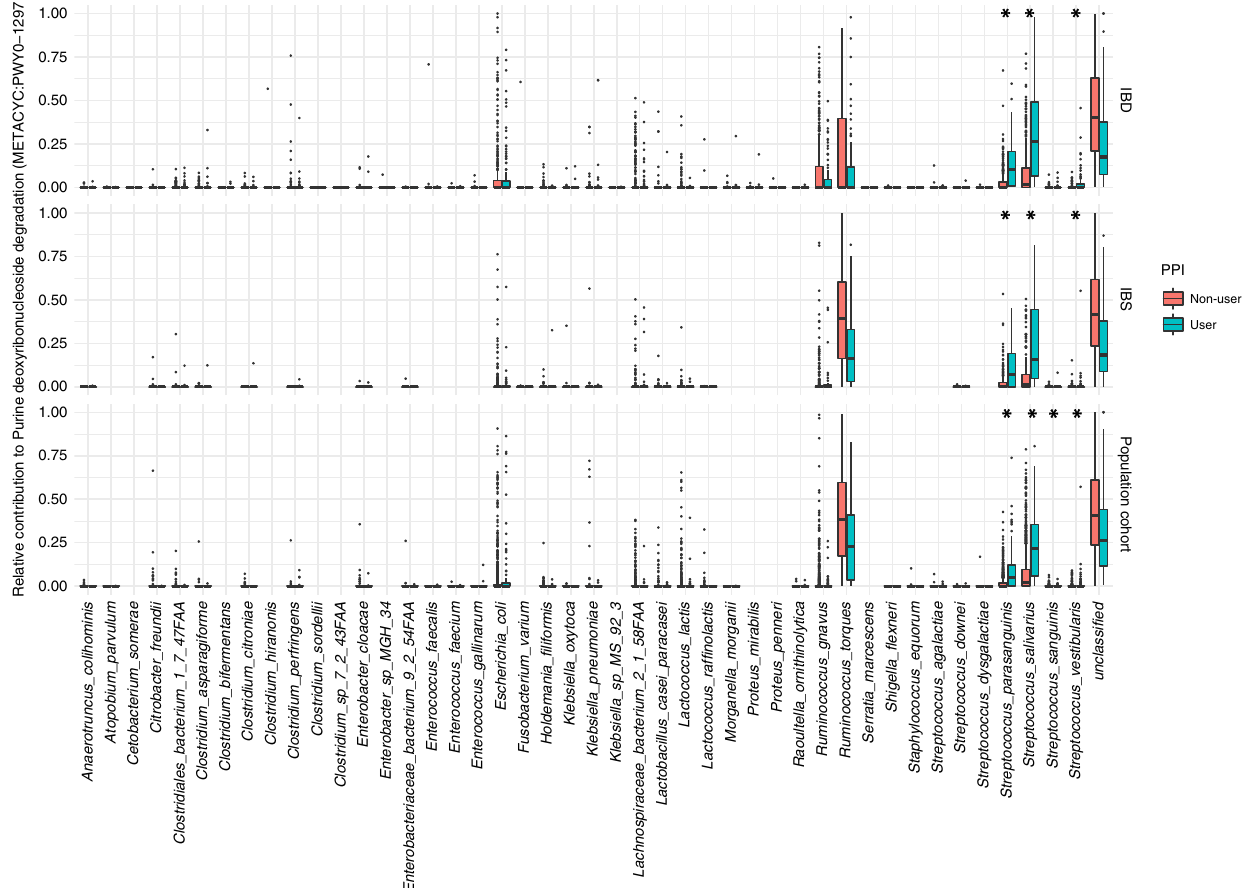
Fig. 4 Microbial contribution to the purine deoxyribonucleoside degradation pathway. Box plots represent the relative contribution of each microbe to the overall pathway quanti fi cation for each cohort separately. On top is the IBD cohort represented, in the middle the IBS cohort and on the bottom row the LLD cohort. Blue box-plots represent the values of PPI users. Red box-plots represent the values of non-PPI users. Asterisks indicate statistically signi fi cant differences between PPI users and non-users (Wilcoxon test, FDR < 0.05). Box plots show medians and the fi rst and third quartiles (the 25th and 75th percentiles), respectively. The upper and lower whiskers extend the largest and smallest value no further than 1.5*IQR, respectively. Outliers are plotted